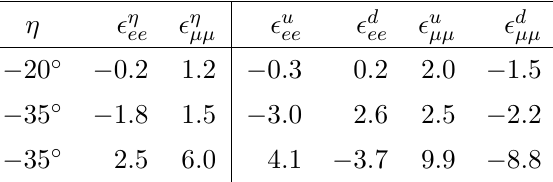
Table 2 . Location of the currently allowed three LMA-dark islands. For each island we give approximate values of η , (cid:15) η , (cid:15) η , as well as the corresponding couplings to up and down quarks, ee µµ see eq.